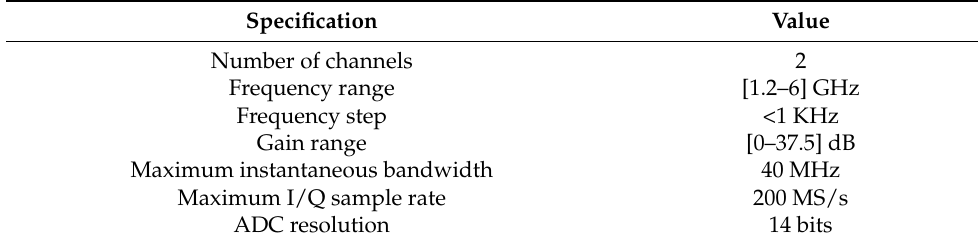
Figure 1. System model for UAV detection. Table 3. Features of USRP-2943 RF receiver [34].